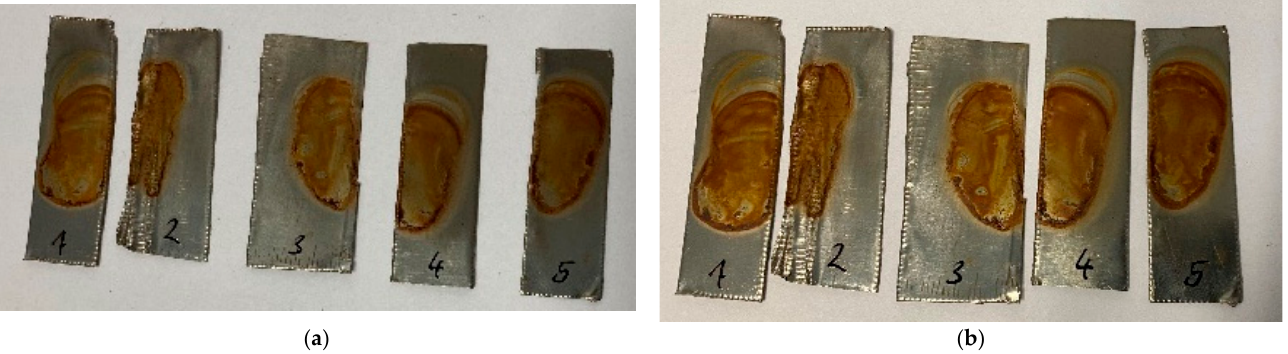
Figure 5. Steel strips after the application of diluted acetic acid ( a ) and directly after reductive low-pressure plasma treatment with Varigon gas for 12 (1), 24 (2), 36 (3), 48 (4), and 60 (5) min ( b ). In comparing these two pictures, no signi fi cant change in the arti fi cial patina is visible.